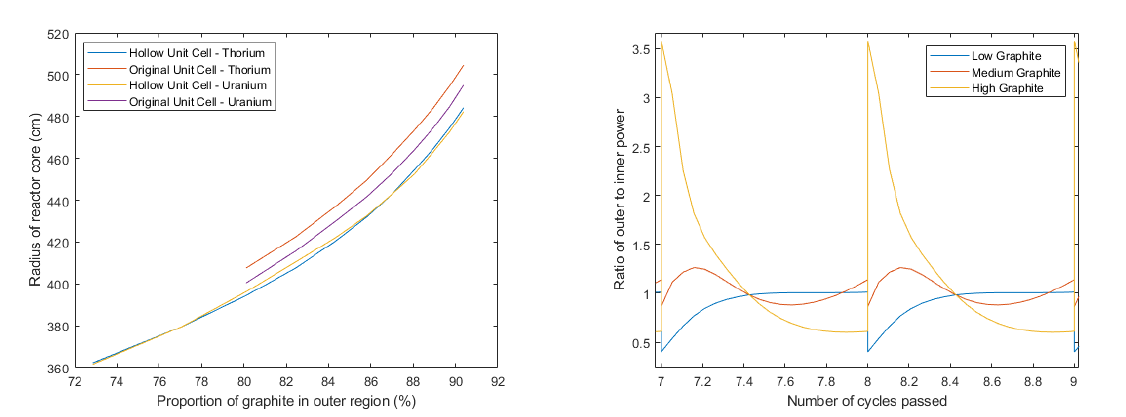
Figure 5: Radii of modelled cores Figure 6: Ratio of powers: inner to outer